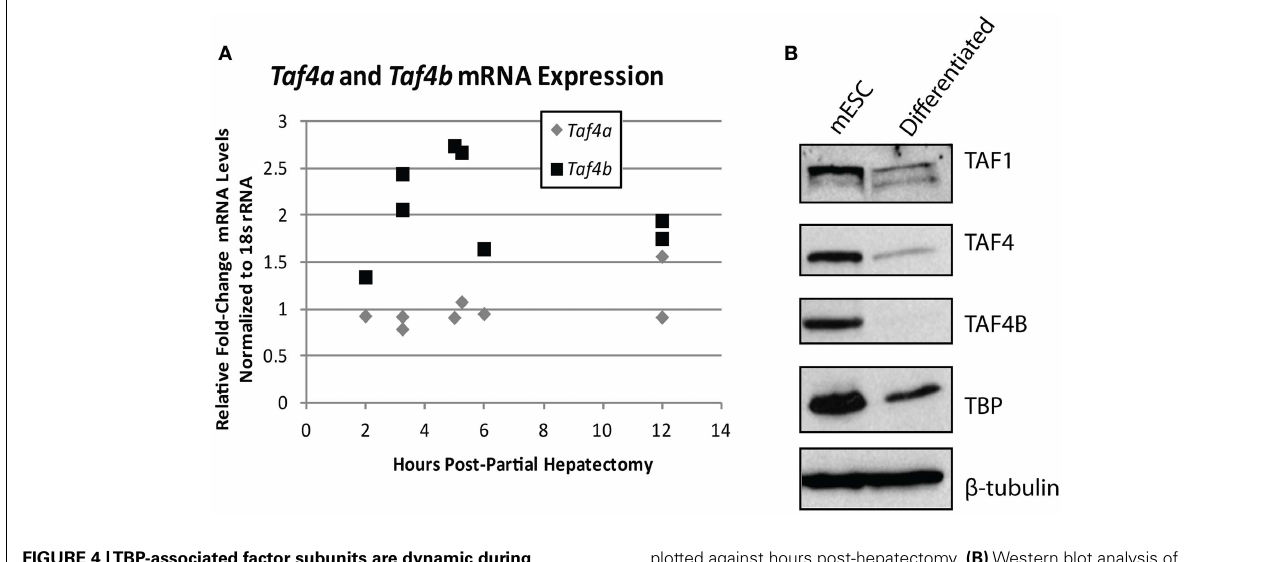
FIGURE 4 |TBP-associated factor subunits are dynamic during differentiation and proliferation . (A) Quantitative RT-PCR analysis of Taf4a and Taf4b in normal (removed) and partial hepatectomy (recovered) mouse livers. Data represented as fold-increase (recovered/removed)